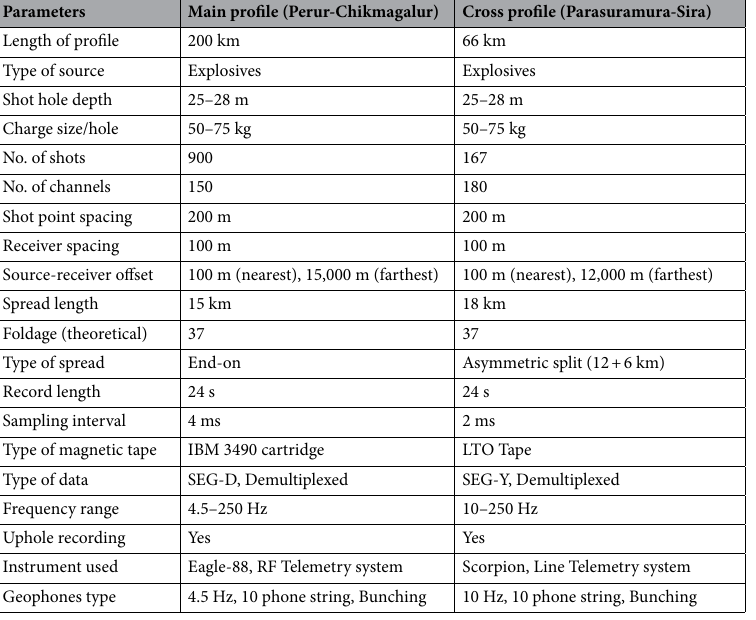
Table 1. Data acquisition parameters for the main and cross